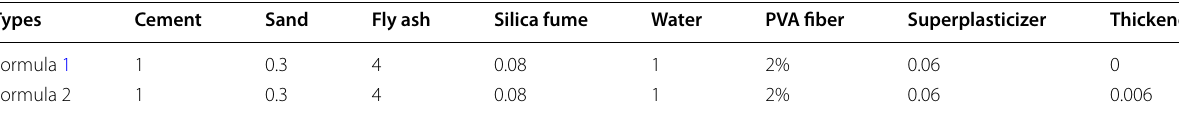
Table 2 Mix proportions of ECC.